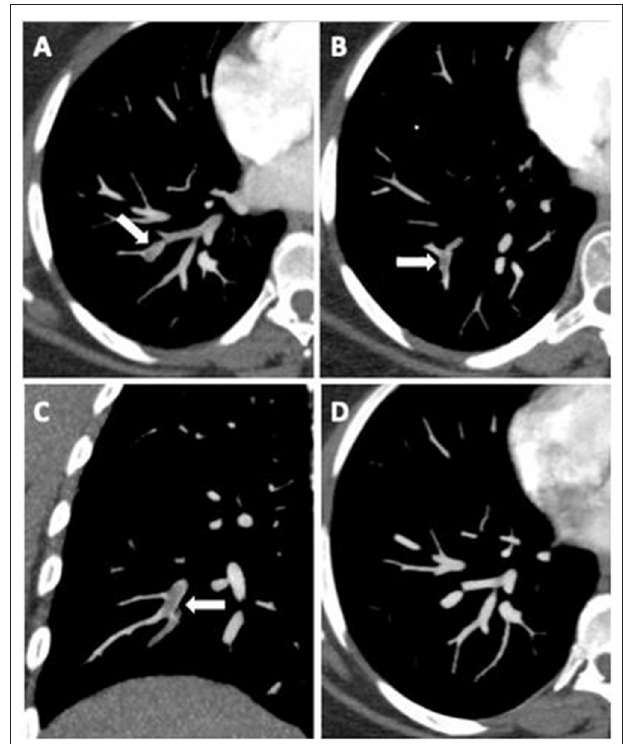
FIGURE 2 | Axial CT images (A,B) and coronal multiplanar reconstruction (C) document partial centric and eccentric opacification defects in the right lower lobe basal segmental arteries (white arrows), suggestive of acute pulmonary embolism. Complete regression after anticoagulant therapy (D)